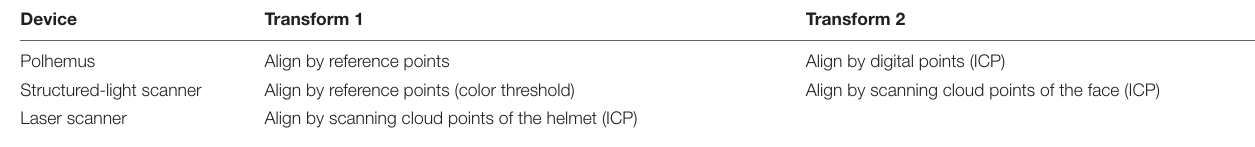
TABLE 1 | Devices used and the corresponding co-registration methods. Device